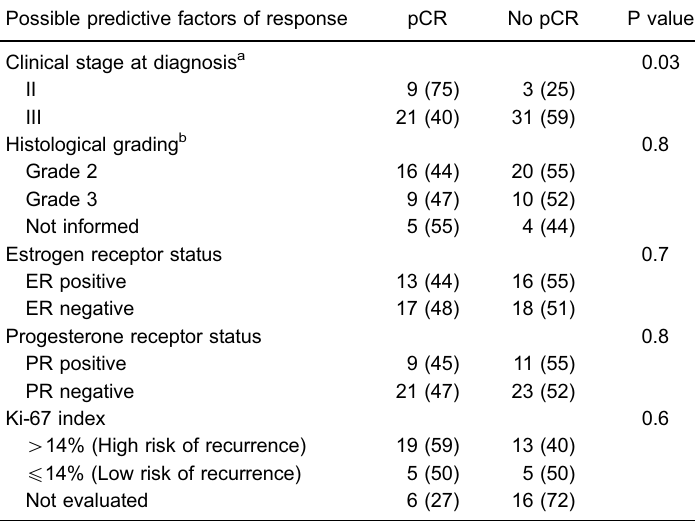
Figure 1 . Disease-free ( A ) and overall ( B ) survival of the 86 patients with HER2-positive breast cancer treated with neoadjuvant chemotherapy (Chemo) with or without trastuzumab (T). All patients received adjuvant treatment with trastuzumab. Log-rank test was used to compare the curves. Table 2. Possible predictive factors of pathologic complete response (pCR) to neoadjuvant chemotherapy with trastuzumab in HER2-positive locally advanced breast cancer